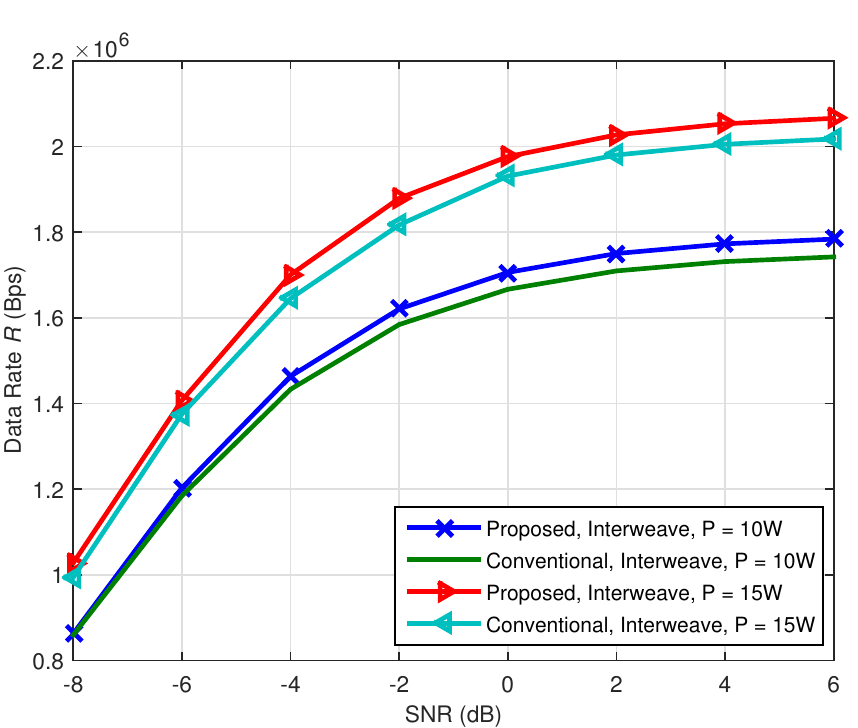
Figure 7. Comparison of the received SNR versus data rate curves between the proposed and conventional methods for interweave CR.